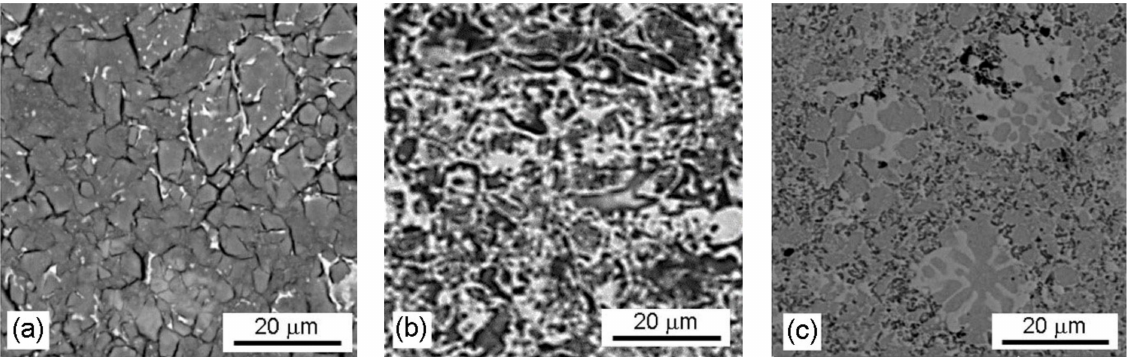
Figure 5. SEM micrographs (BSE) of the exposed surfaces of Mn-based alloys after the corrosion test in model seawater: ( a ) 0% Al, ( b ) 10% Al, and ( c ) 20%